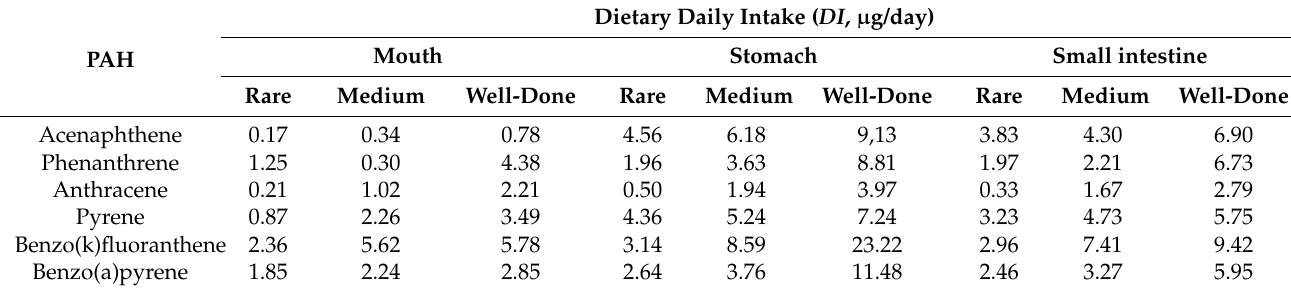
Figure S1: Schematic diagram of the in vitro digestive procedure (Adapted from